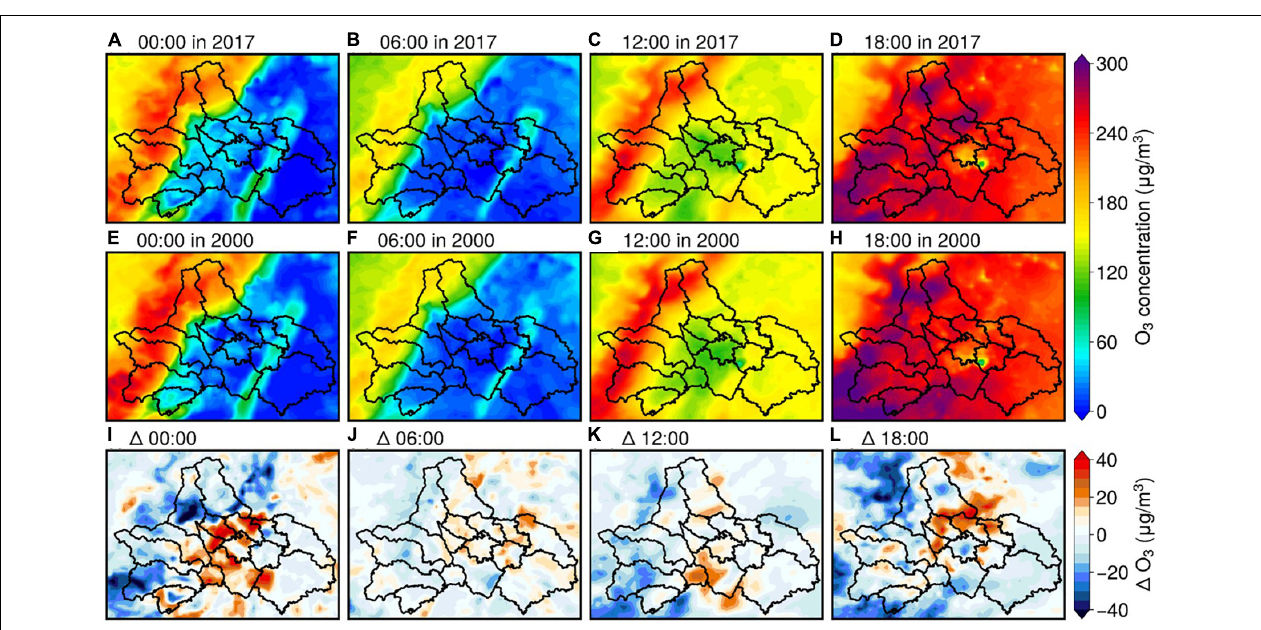
FIGURE 10 | Spatial map of simulated O 3 levels and O 3 variations induced by land use change between 2000 and 2017 at 00:00, 06:00, 12:00, and